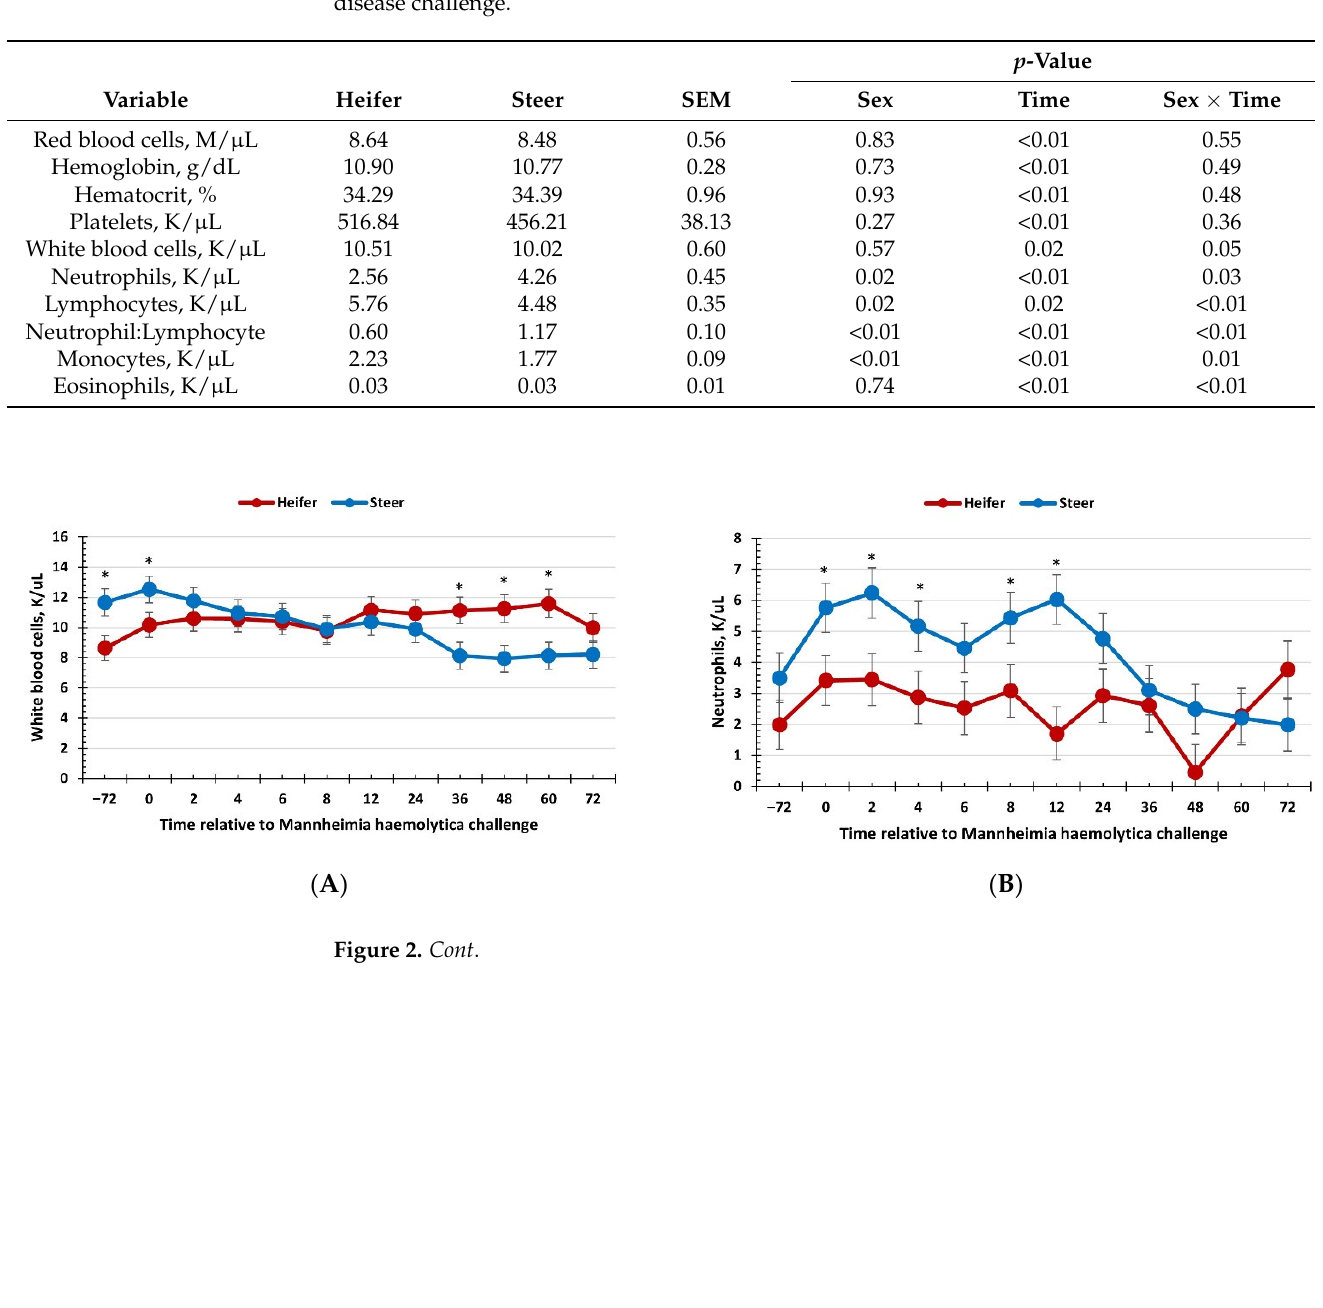
Table 2. Influence of sex on the complete blood count response to a dual viral–bacterial respiratory disease challenge.